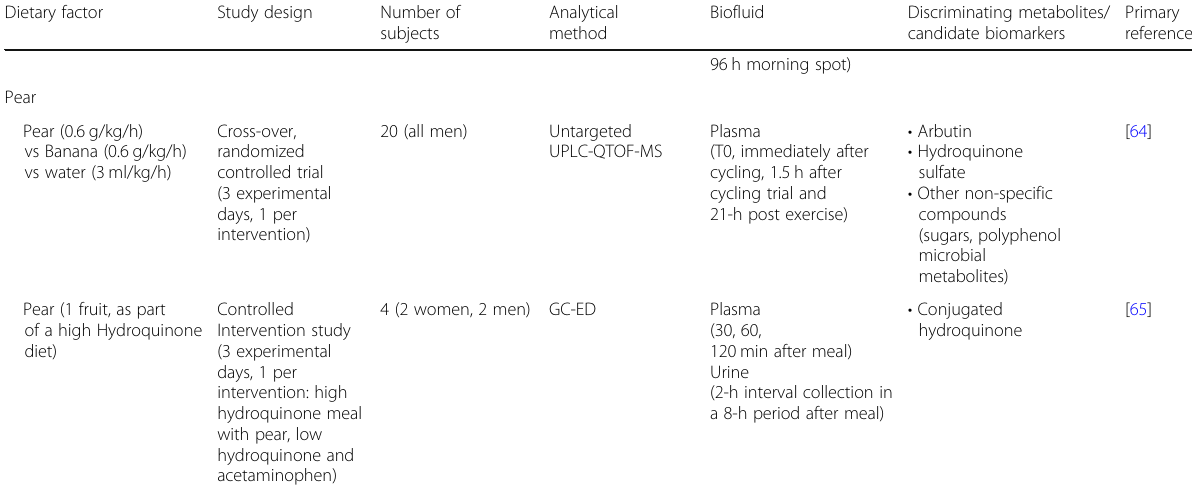
Table 1 List of studies reporting candidate biomarkers for pome fruit consumption (Continued) Dietary